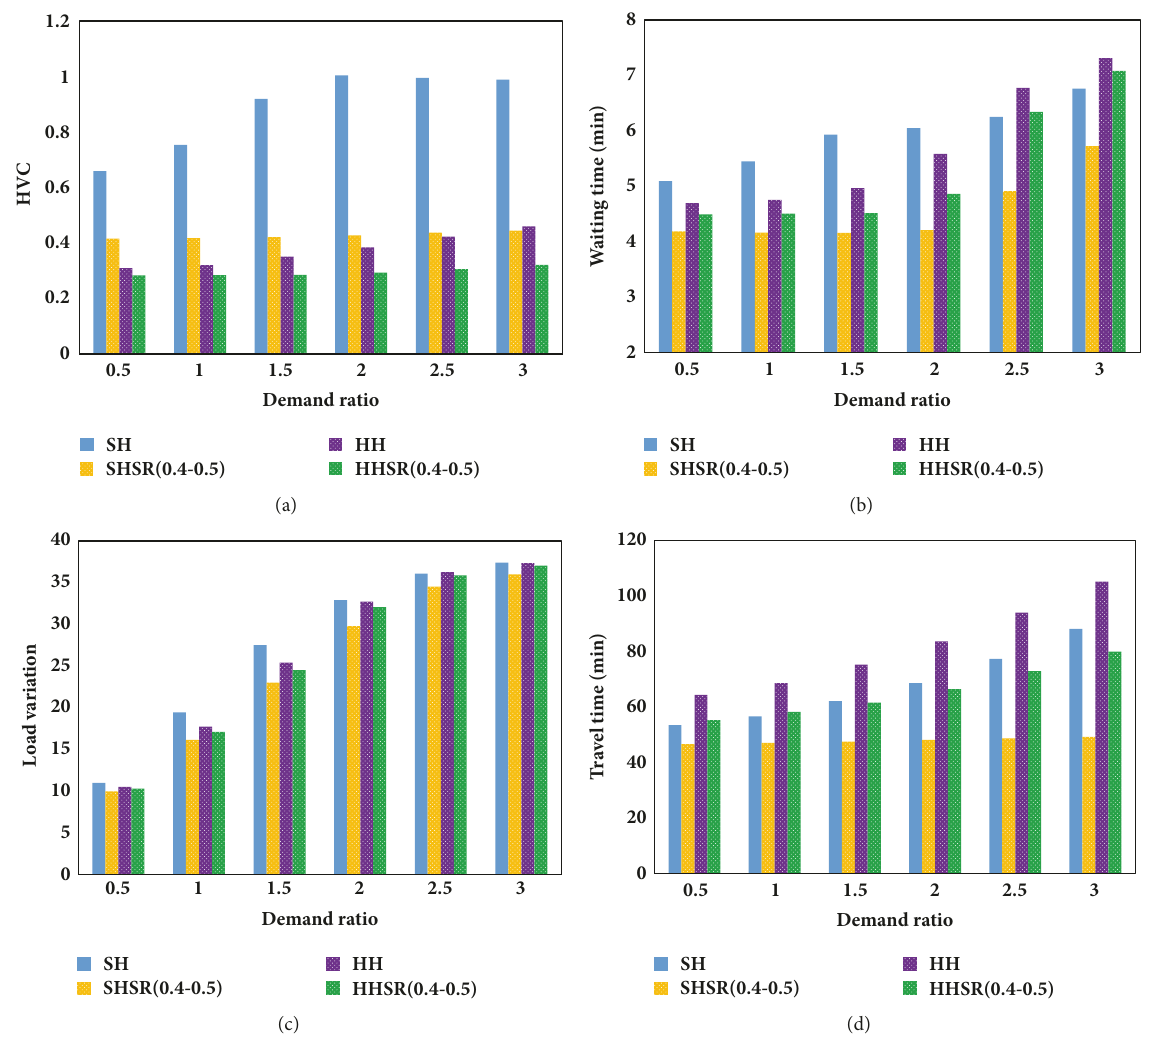
Figure 5: Performance measures for different total demand: (a) HVC; (b) 𝐸(𝑤) ; (c) average travel time; (d) load variation.